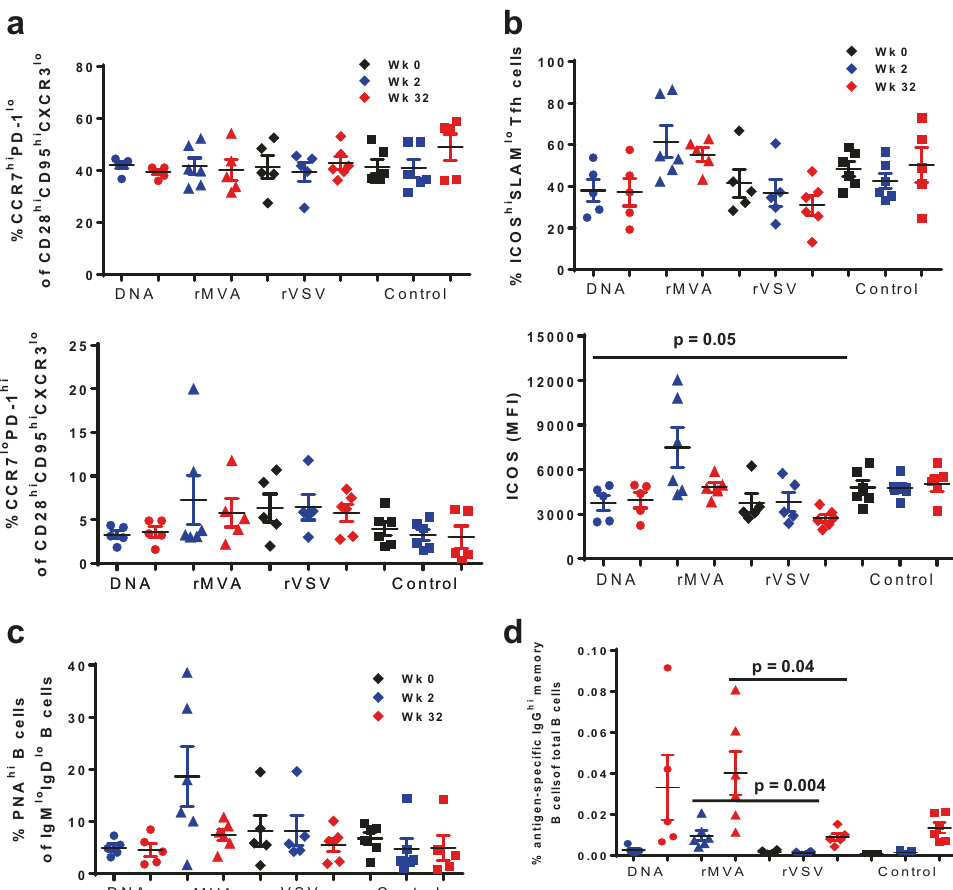
Fig. 4 Increased expression of ICOS on Tfh CD4 + T cells is associated with induction of Env-speci fi c B-cell responses after priming with rMVA. In each panel, black symbols denote pre-immunization (Week 0), blue symbols post-prime (Week 2) and red symbols show post-boost measurements. Plasmid DNA group is represented by using circles, rMVA by triangles, rVSV by diamonds, and control group by squares. Bars depict SEM. a Both upper and lower panel show the percentages of Tfh CD4 + T cells based on the expression of CCR7 and PD-1 in lymph node-derived lymphocytes. b Upper panel shows the percentages of ICOS hi SLAM lo Tfh CD4 + T cells for individual monkeys from each vaccine group at weeks 0, 2, and 32. Lower panel shows the expression of ICOS per Tfh CD4 + T cell — based on Mean Fluorescence Intensity (MFI). c Dot plots showing accumulated data of relative frequencies (%) of bulk germinal center memory B cells in lymph node (LN) tissues at the indicated time points as judged by PNA staining — memory B cells in LN tissues obtained at the indicated time points. d Immunogen-speci fi c B cells responses were detected by using a speci fi c Env probe in bulk memory B cells from LN tissues. The relative frequencies are shown as a percentage of total B cells. All LN samples were analyzed in one experiment. Non-parametric Mann – Whitney U test was used for the statistical analysis and mean and SEM are shown for each vaccine